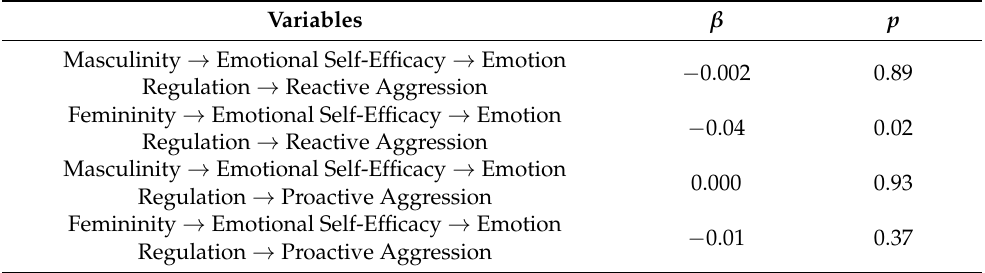
Table 2. Indirect